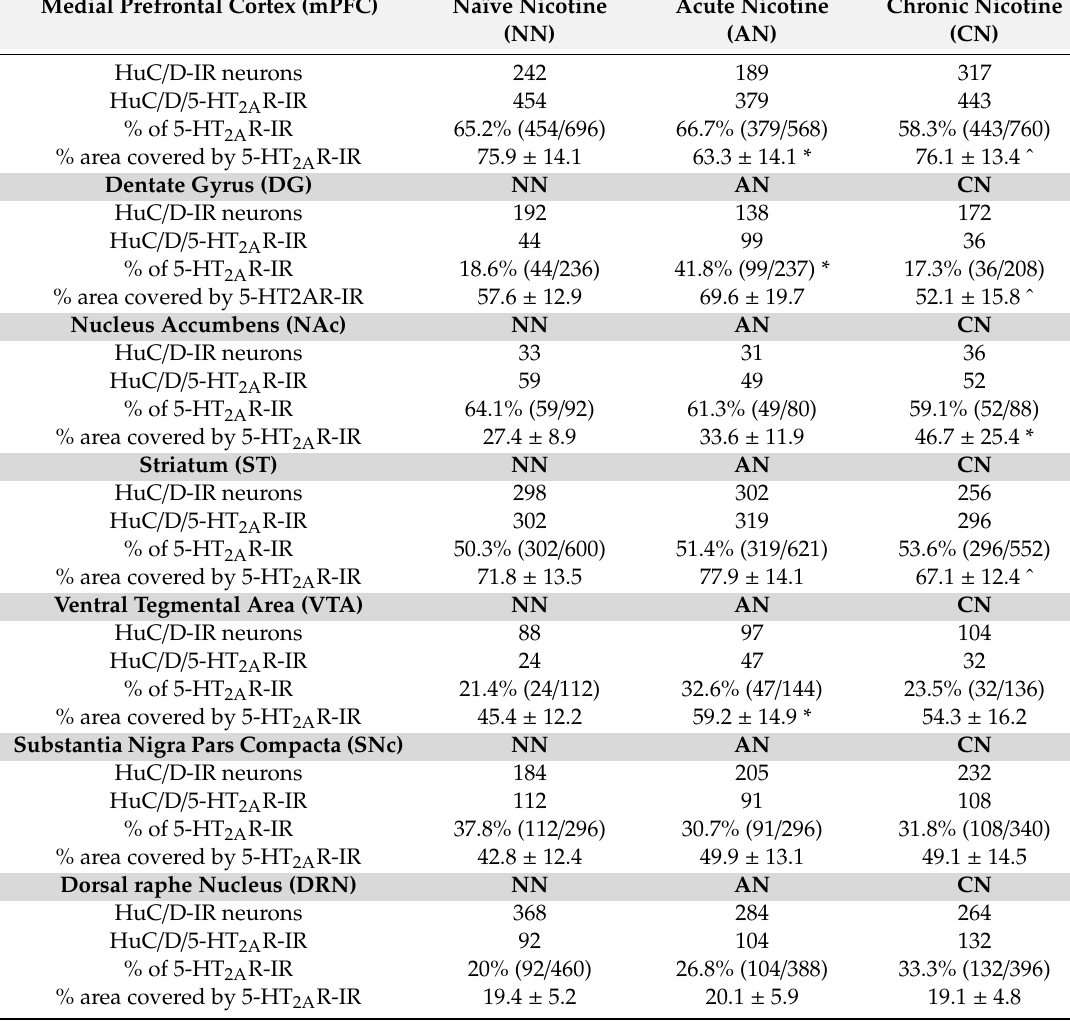
Table 2. Colocalization of HuC / D with 5-HT 2A receptor (5-HT 2A